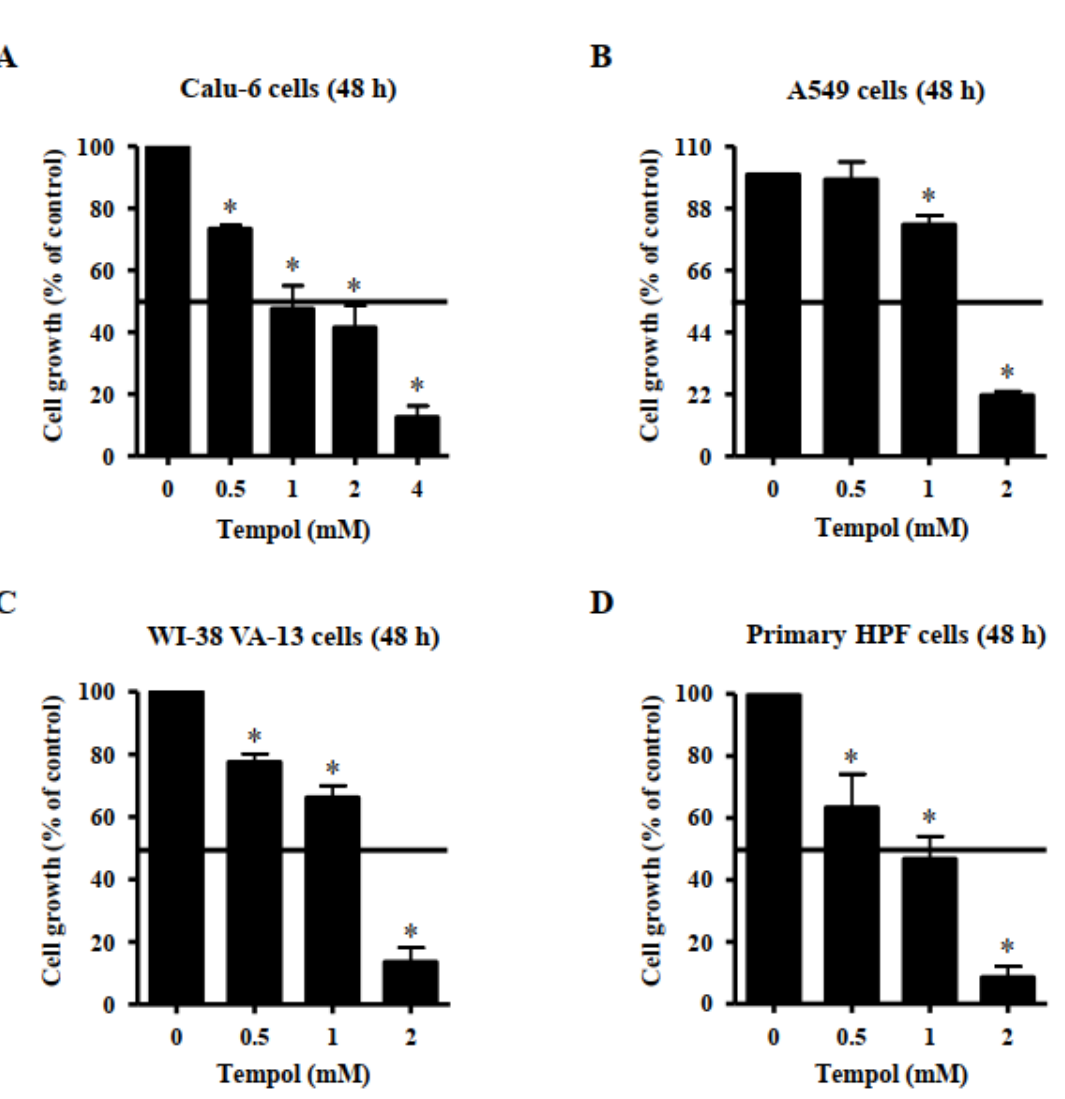
Figure 1. Effects of Tempol on the growth of normal and lung cancer cells. Exponentially growing cells were incubated with Tempol at indicated concentrations for 48 h. Cell growth was evaluated by MTT assays. Graphs show the growth of Calu-6 cancer cells ( A ), A549 cancer cells ( B ), WI-38 VA-13 normal cells ( C ), and primary HPF normal cells ( D ). Student’s t -test was used. * p < 0.05 compared to Tempol-untreated control cells.